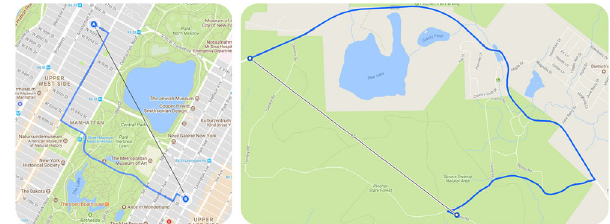
Due to the underlying routing approach and targeting, standard routing approaches fail to locate control points that are off-grid. In this case, massive detours occur that are undesirable for GPS art.